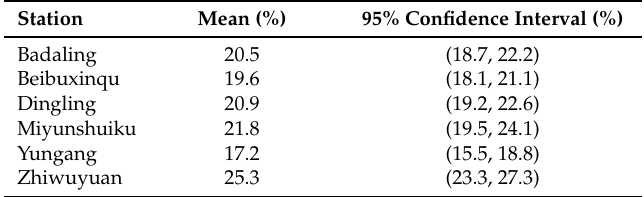
Table 4. Contribution (%) of road traffic to PM 2.5 concentrations of background stations.